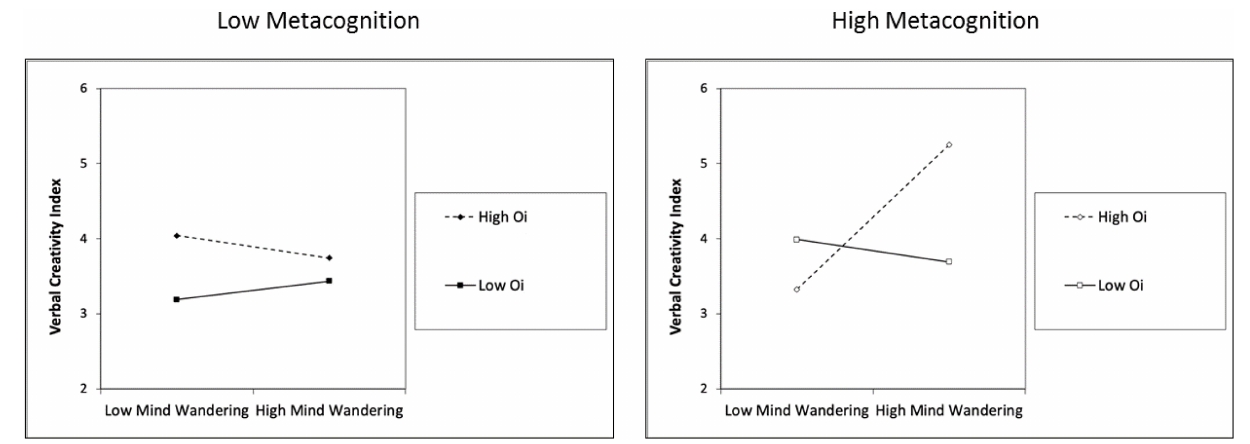
FIGURE 1 | Mind wandering effect on creativity moderated by attentional capacity and